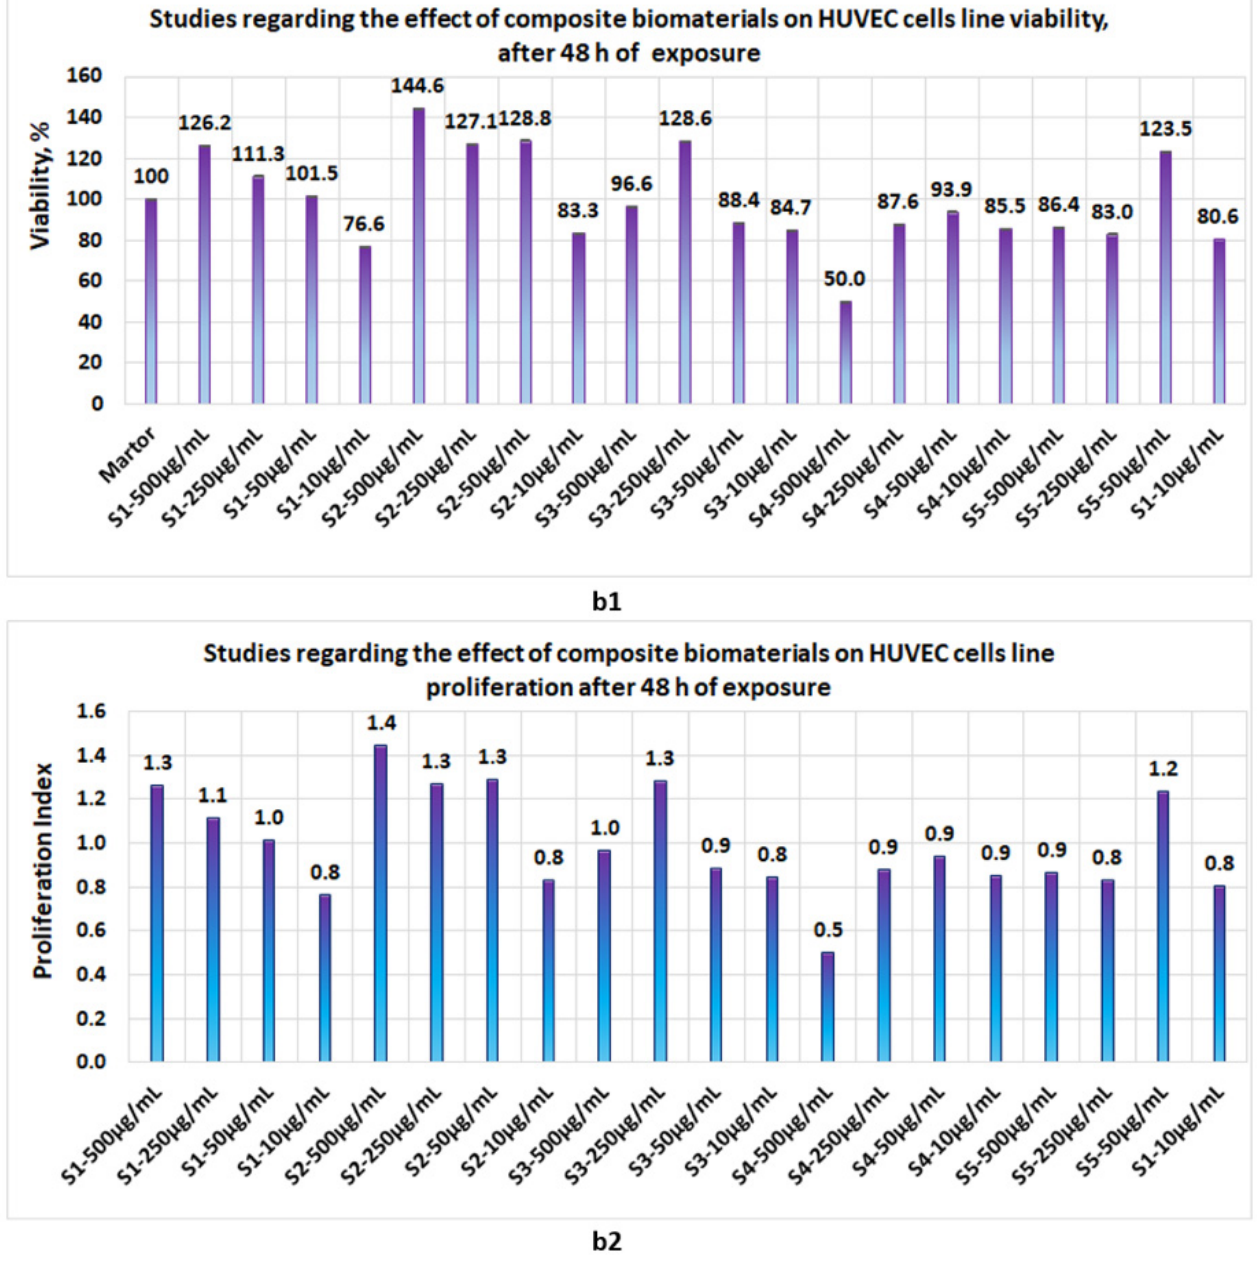
Figure 13. Studies regarding the effect of composite biomaterials on HUVEC cell lines after 48 h of exposure; ( b1 ) influence on cell viability; ( b2 ) influence on cell proliferation.